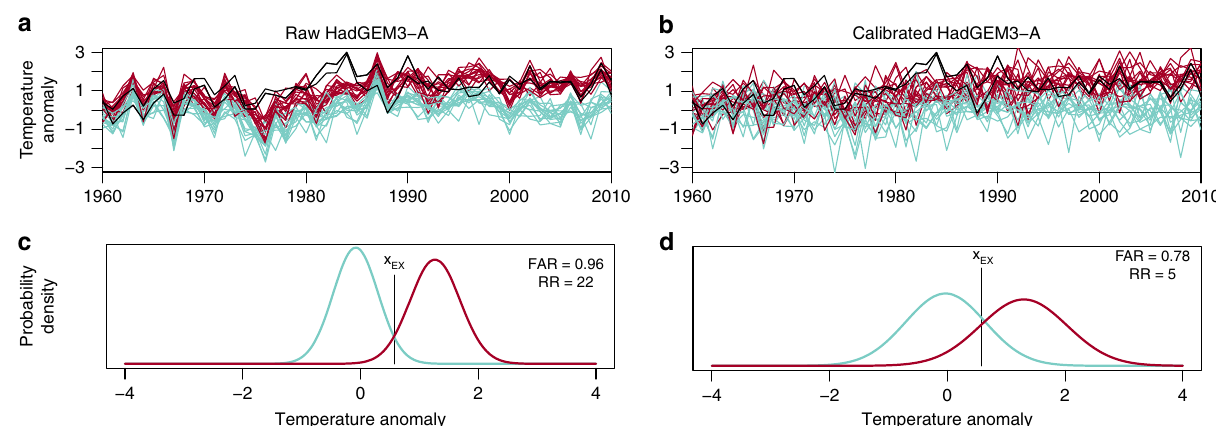
Fig. 1 Effect of ensemble calibration on an attribution case for boreal hot summers for a grid point in Sudan (12.6°N, 34.4°W). Panels a and b show the observed historical evolution of summer temperatures (black, two different datasets) and the single-model ensemble of the UK quasi-operational attribution system (HadGEM3-A) considering all forcings (red) and only natural forcings (blue) as anomalies from present day climatology (1981 – 2010) derived from the all forcings ensemble. Panels c and d show the probability distribution of temperature and the associated fraction of attributable risk (FAR) due to climate change (distribution red opposed to the blue one) for a 1 in 5-year event in the NAT simulation ( x EX )